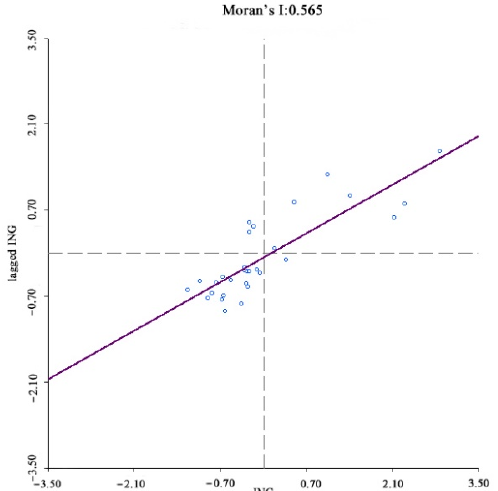
Figure 4. Global Moran’s I of rural residents’ income growth.